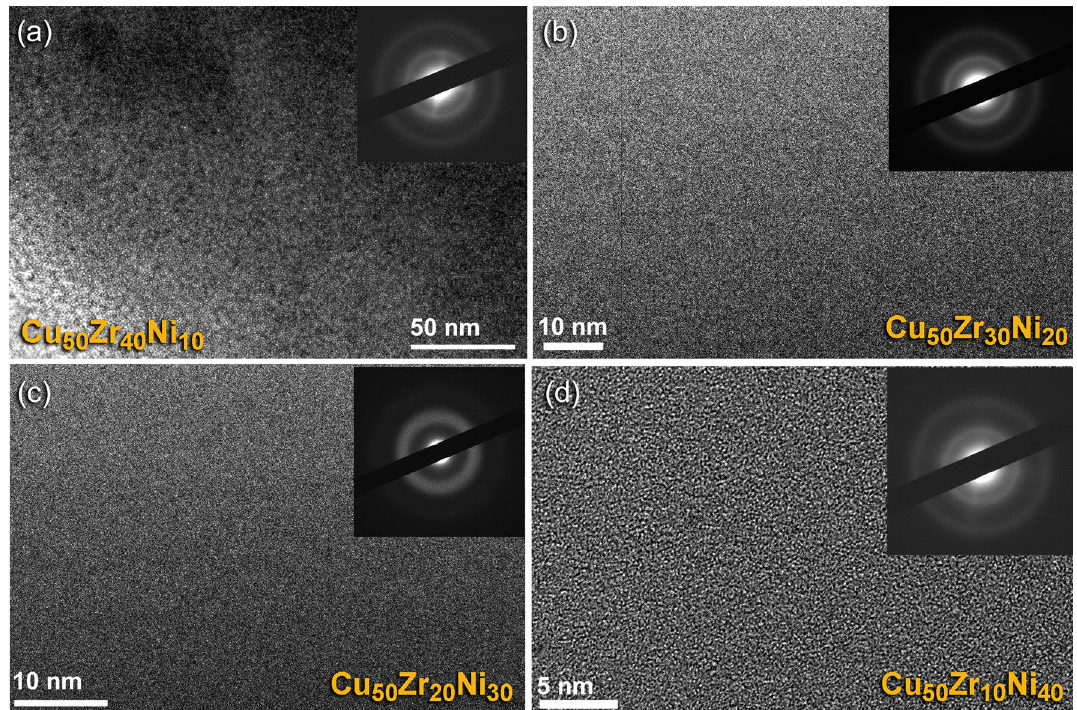
Figure 9. Local structure of the final product of MG Cu 50 (Zr 50−x Ni x ) systems. FE-HRTEM, and related nanobeam diffraction patterns (NBDPs) of ( a ) Cu 50 Zr 40 Ni 10 , ( b ) Cu 50 Zr 30 Ni 20 , ( c ) Cu 50 Zr 20 Ni 30 , and ( d ) Cu 50 Zr 10 Ni 40 obtained after 50 h of MA